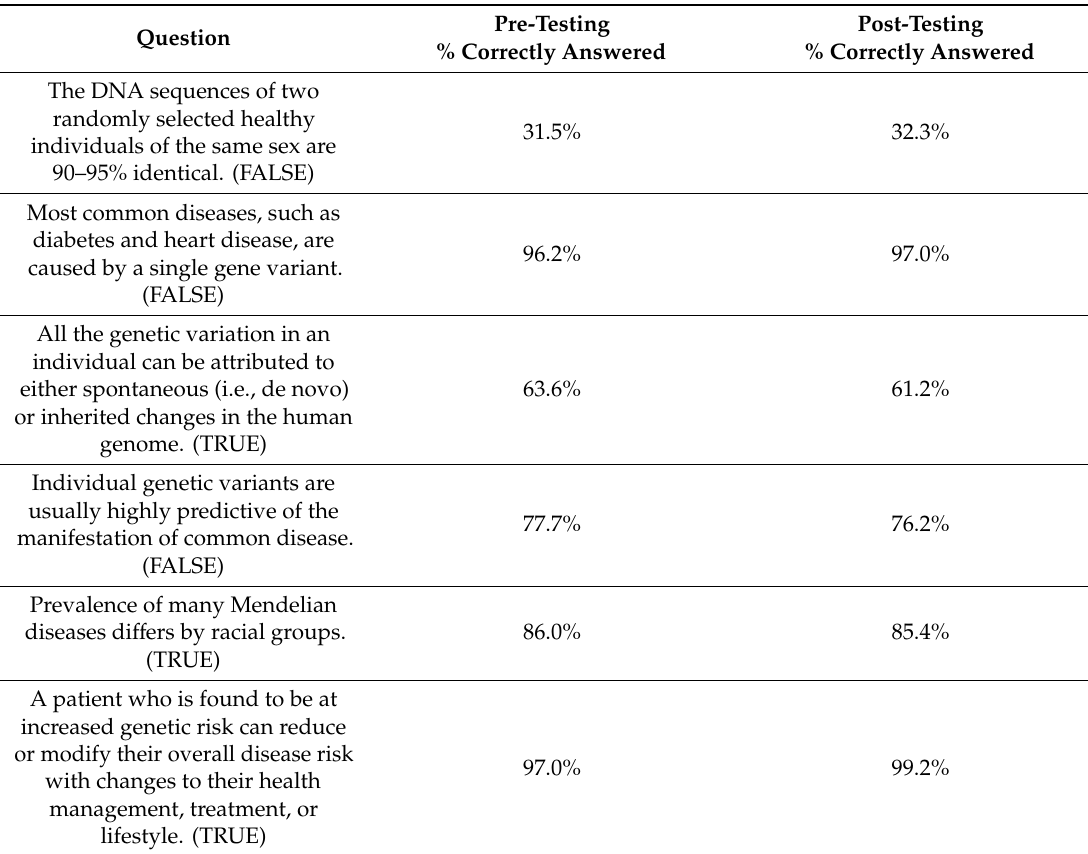
Table 5. Factual knowledge among respondents who completed the pre and post-testing survey ( n =